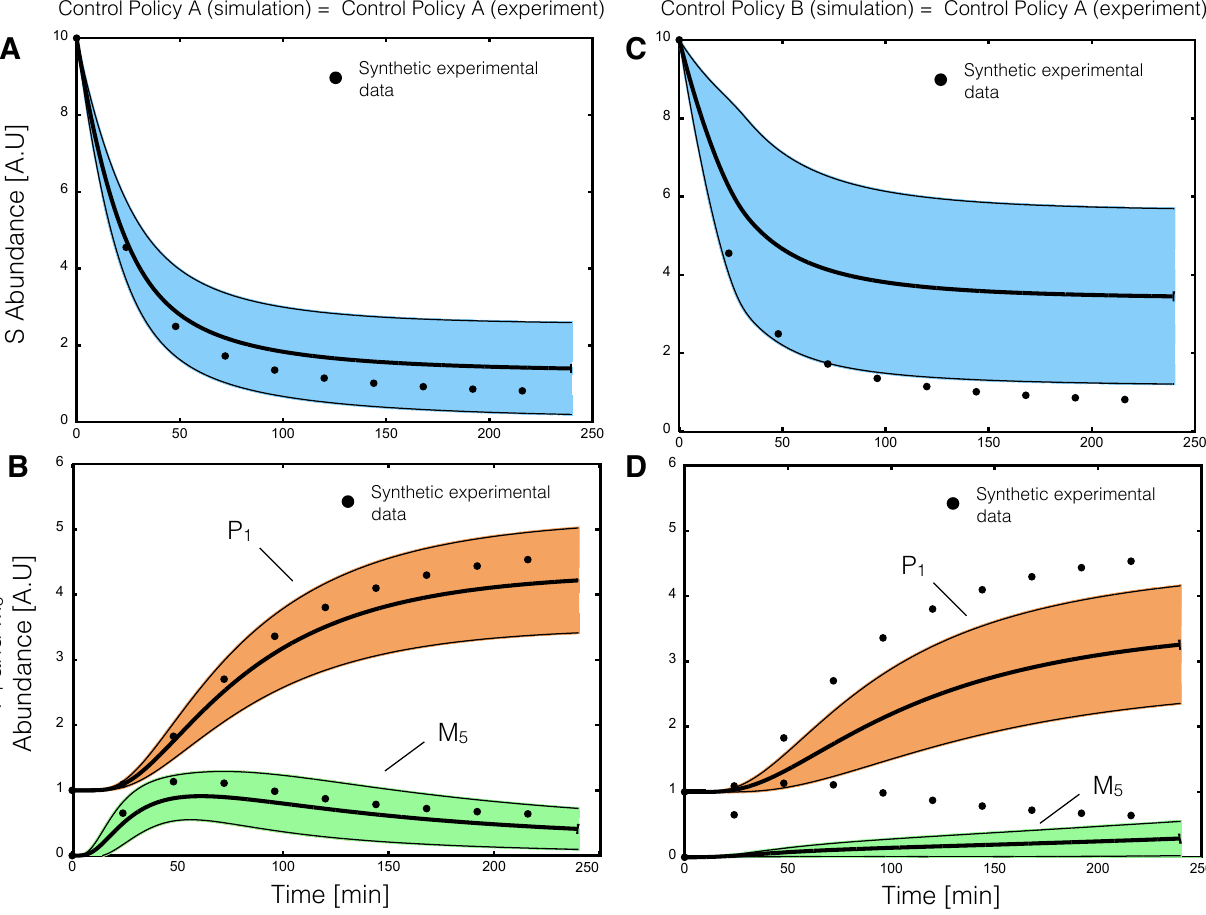
Figure 5. Parameter estimation from synthetic data for the same and mismatched allosteric control logic using particle swarm optimization (PSO). Synthetic experimental data was generated from a hypothetical parameter set using Network A, where substrate S , end product P and intermediate M were sampled approximately every 20 min. For cases 1 5 ( A , B ) 20 particles were initialized with randomized parameters and allowed to search for 300 iterations. ( A , B ) PSO estimated an ensemble of 20 parameters sets consistent with the synthetic experimental data assuming the correct enzymatic and control connectivity starting from randomized initial parameters; ( C , D ) In the presence of control mismatch (Network B control policy simulated with Network A kinetic parameters) the ensemble of models did not describe the synthetic data. The synthetic data plotted here was unperturbed by noise. However, we assumed a constant coefficient of variation of 10% for the synthetic data during parameter